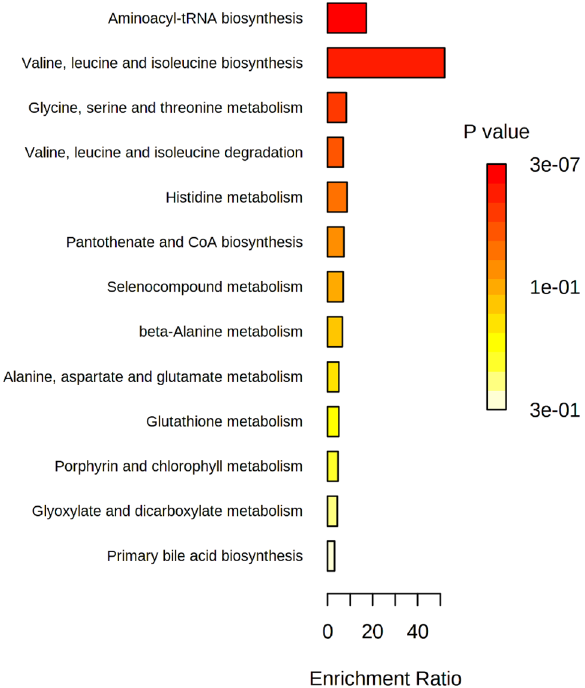
Figure 2. Pathway analysis. Enrichment overview (Metaboanalyst software version